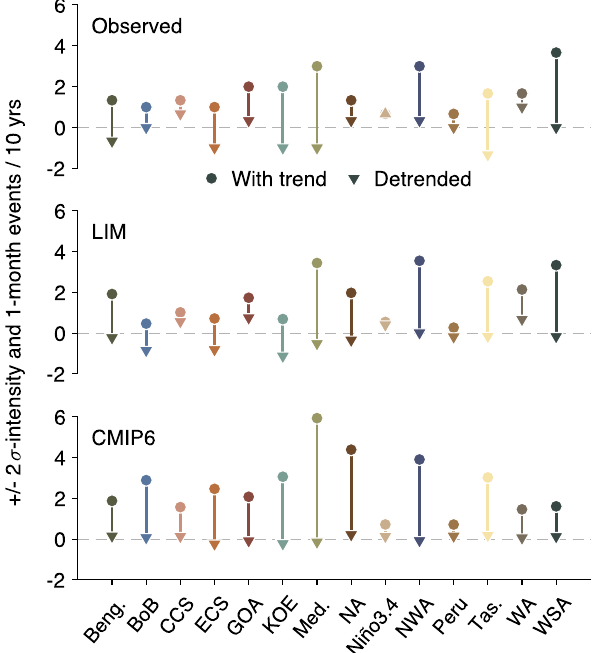
Fig.7|ChangesinMarineHeatwave(MHW)occurrencesatregionsofhistorical events, before (circles) and after detrending (triangles). Circles (triangles) represent increased or decreased MHW frequencies between 1958 – 1987 and 1988 – 2017, derived from dataset with the trend (without trend): (top) observed, (mid)LIM, and (bottom)CMIP6.NotethatMHWeventsareidenti fi edbased onthe 2 σ intensity and 1 month duration. Qualitatively similar results are found using other pairs of thresholds to de fi ne MHW events (Supplementary Fig.